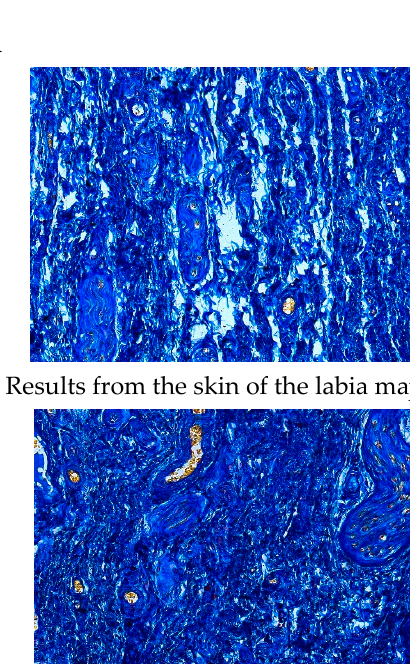
Figure 14. The comparison of specimens stained with orcein before and after the treatment revealed 11.43% rise in elastin concentration.